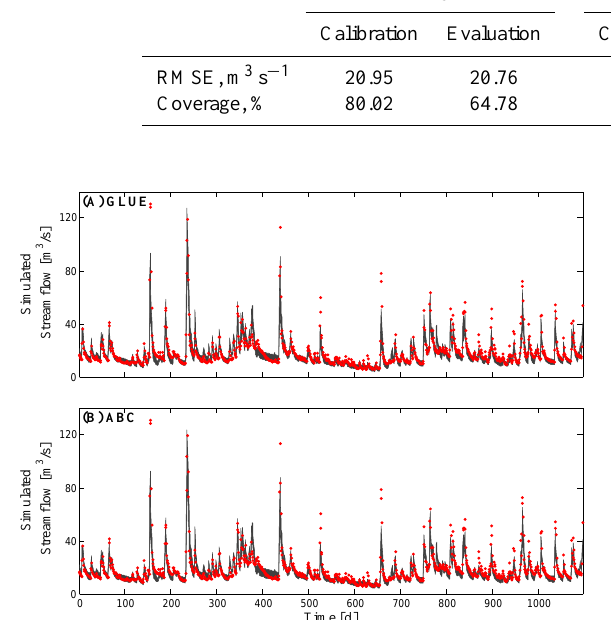
Fig. 12. Hmodel derived 95% streamflow simulation uncertainty ranges (grey region) for a three-year portion of the evaluation pe- riod of the French Broad river basin using the (A) GLUE and (B) ABC derived posterior parameter distribution. The observed dis- charge data are indicated with the solid red dots.